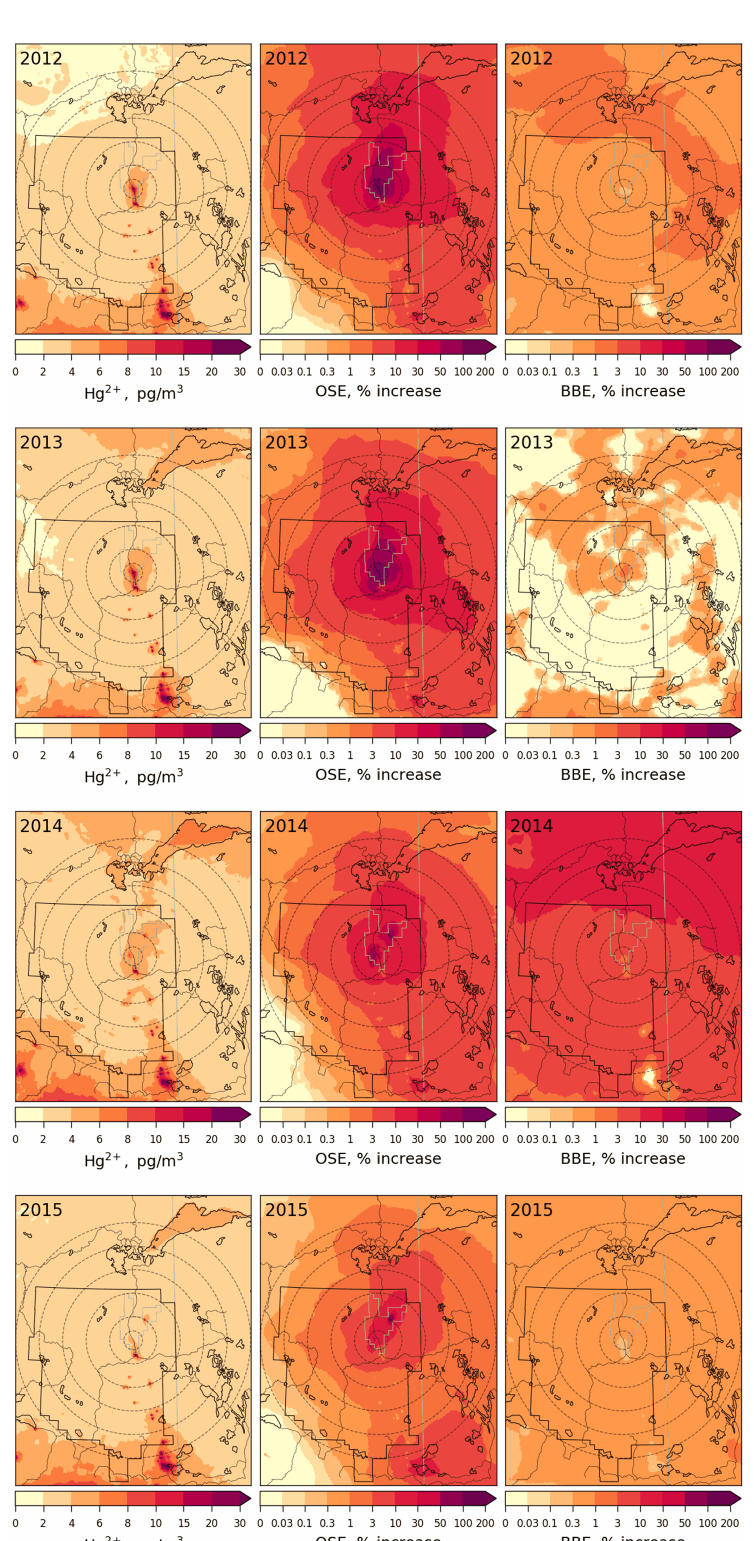
Figure 13. Annual average surface air concentration of TOM (sum of GOM and PBM, left) and concentration enrichments (%) due to Hg emissions from Athabasca oil sands operation (OSE, middle) and biomass burning in North America (BBE, right) for the years 2012–2015. AOSR is marked as an approximate rectangle, and concentric distance circles are at 20, 50, 100, 150, 200 and 250km from